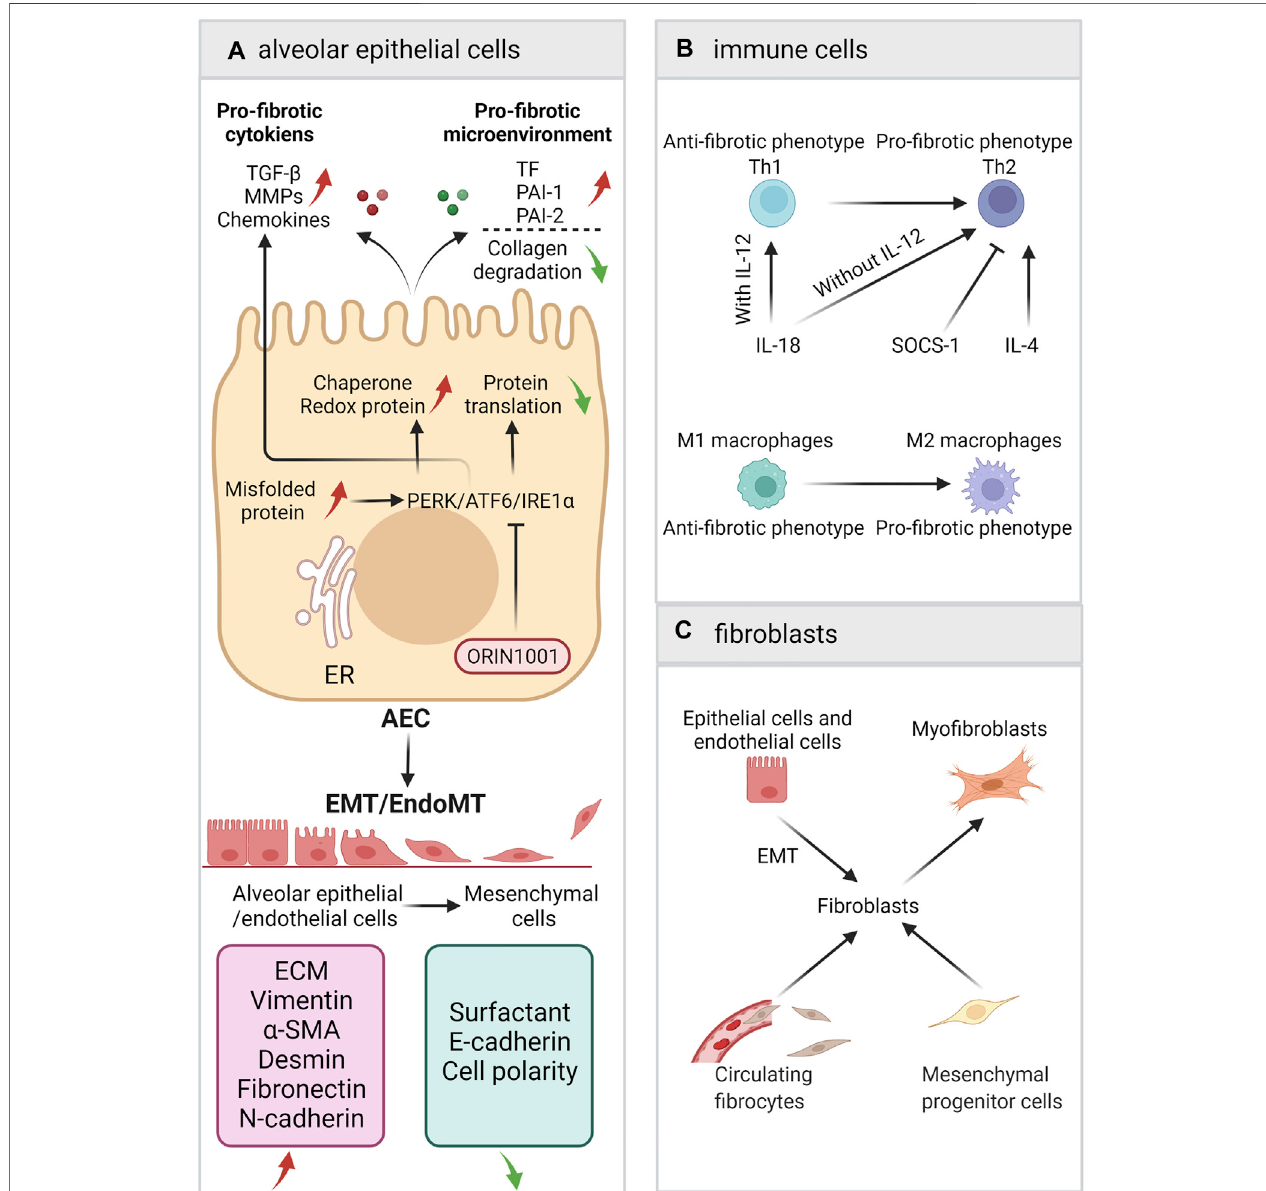
FIGURE 2 | A schematic view of the roles of AECs, immune cells and fi broblasts. (A) Alveolar epithelial cells/endothelial cells participate in IPF via ER stress/UPR, EMT, coagulation cascade, and the secretion of a variety of signaling factors. (B) The balance of Th1/Th2 and M1/M2. (C) The sources of fi broblasts and the fi broblast- to-myo fi broblasts